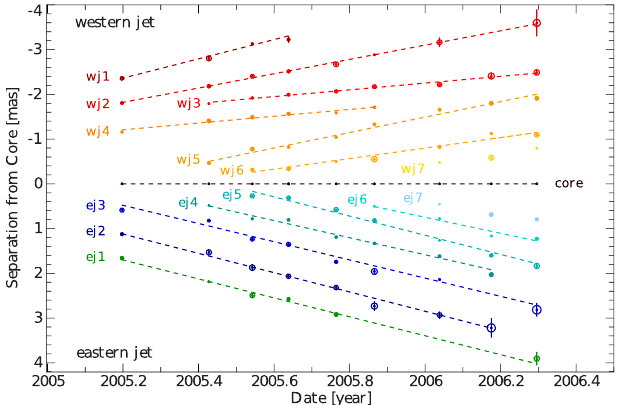
Figure 2. Component core-separation evolution for observations from 2005 and